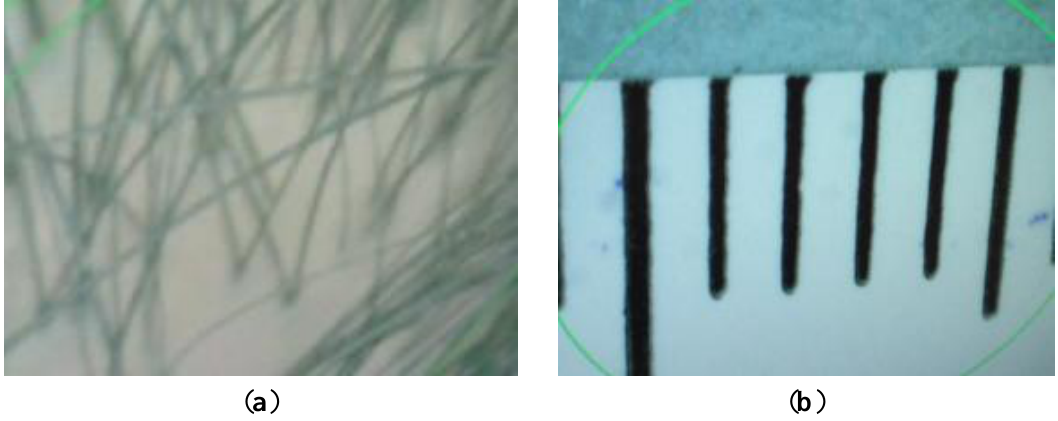
Figure 1. Sample images captured by a commercial device to diagnose a patient’s skin. ( a ) Captured image including hair and scalp; ( b ) Image showing the zooming factor of the